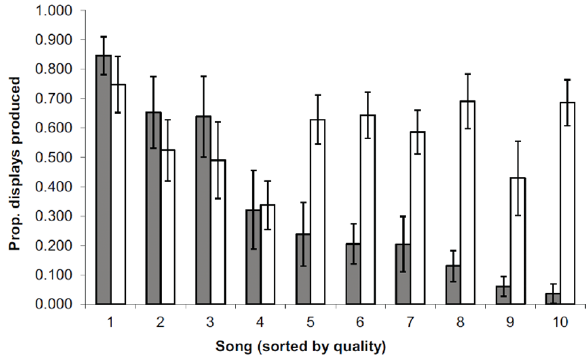
Figure 2. Lesions of the song control system cause females to lose song selectivity. Mean ( 6 1 SEM) proportion of copulation solicitation displays produced by lesioned (open bars) and sham- lesioned (filled bars) females for playbacks of 10 local cowbird songs in experiment 1. Songs are ordered based on song quality as ranked by the displays of unmanipulated females in prior years of playback testing.